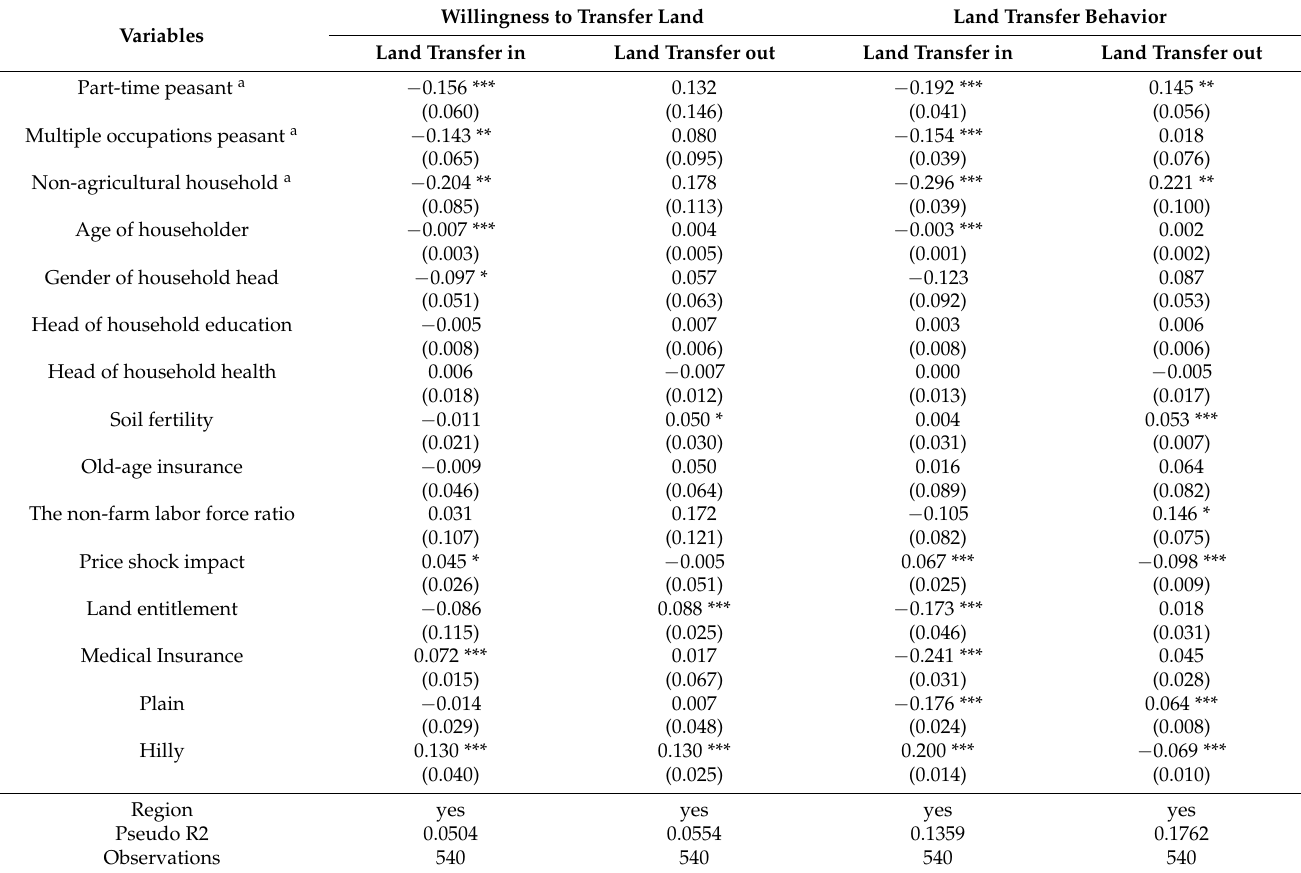
Table 2. Binary probit estimation results of peasants’ willingness to transfer land and behavior.